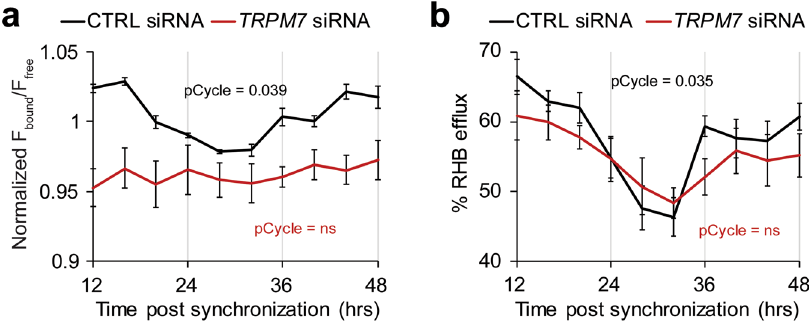
Fig. 6 Knockdown of TRPM7 reduces and dampens rhythms of intracellular Mg 2 + and xenobiotic ef fl ux. Stable hCMEC/D3 cell lines containing scrambled siRNA and GFP or TRPM7 siRNA and GFP were made with Lentiviral transduction. Stable lines were synchronized with dexamethasone and assayed at the indicated time points. a Knockdown of TRPM7 results in reduced Mg 2 + and loss of cycling. Generated cell lines were incubated with intracellular magnesium indicator Magfura2-AM at the indicated time points after dexamethasone synchronization and measured at ex330/em490 (free) ex369/em490 (bound) using a plate reader. Means of normalized fl uorescence of bound Magfura2 (F bound ) over the fl uorescence of free Magfura2 (F free ) ± SEM are shown ( n = 50; 10 time points, 5 independent experiments). p < 0.0001 comparing control to TRPM7 siRNA cell line by paired T-test, showing less intracellular Mg 2 + in the siTRPM7 cell line across time points. pCycle values were calculated by JTKCycle analysis. b Knockdown of TRPM7 reduces xenobiotic ef fl ux and dampens rhythms. Cells were synchronized with dexamethasone and RHB ef fl ux assay was performed at the indicated time point. Control or TRPM7 siRNA-treated suspended cells were incubated with RHB on ice for 15 min. Excess RHB was removed and half of the culture was incubated at 37 °C for 30 min to allow for optimal ef fl ux conditions while the rest remained on ice. The amount of intracellular RHB was determined by fl ow cytometry. The percentage of RH123 fl uorescence ef fl uxed in 30 min comparing the level of fl uorescence in cultures with or without 37 °C incubation is shown as means ± SEM ( n = 40; 10 time points, 5 independent experiments. pCycle values were calculated by JTKCycle analysis. p = 0.0085 comparing